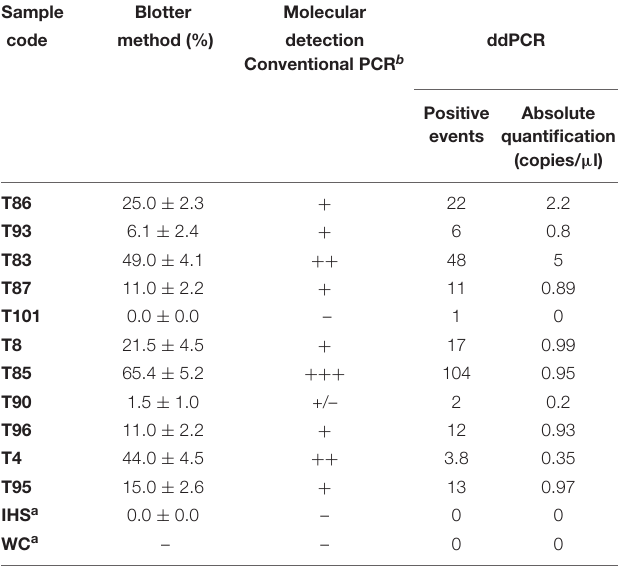
TABLE 3 | Comparative detection of Stagonosporopsis cucurbitacearum in the naturally infected seed samples, according to the blotter analysis and conventional PCR and